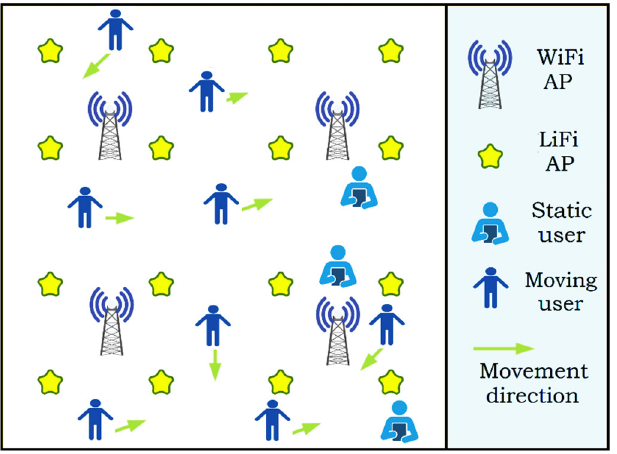
Figure 7. Simulation scenario.